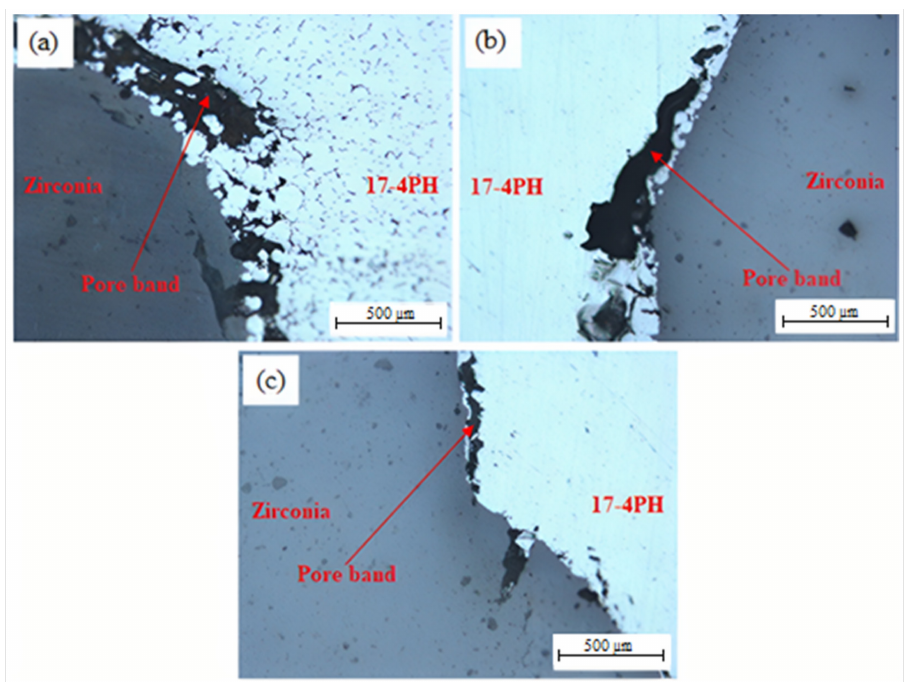
Figure 11. Optical microscopy images displaying the interfaces of 17-4PH/zirconia micro-sized components sintered for 3 h at various temperatures: ( a ) 1250 ◦ C; ( b ) 1300 ◦ C; ( c ) 1350 ◦